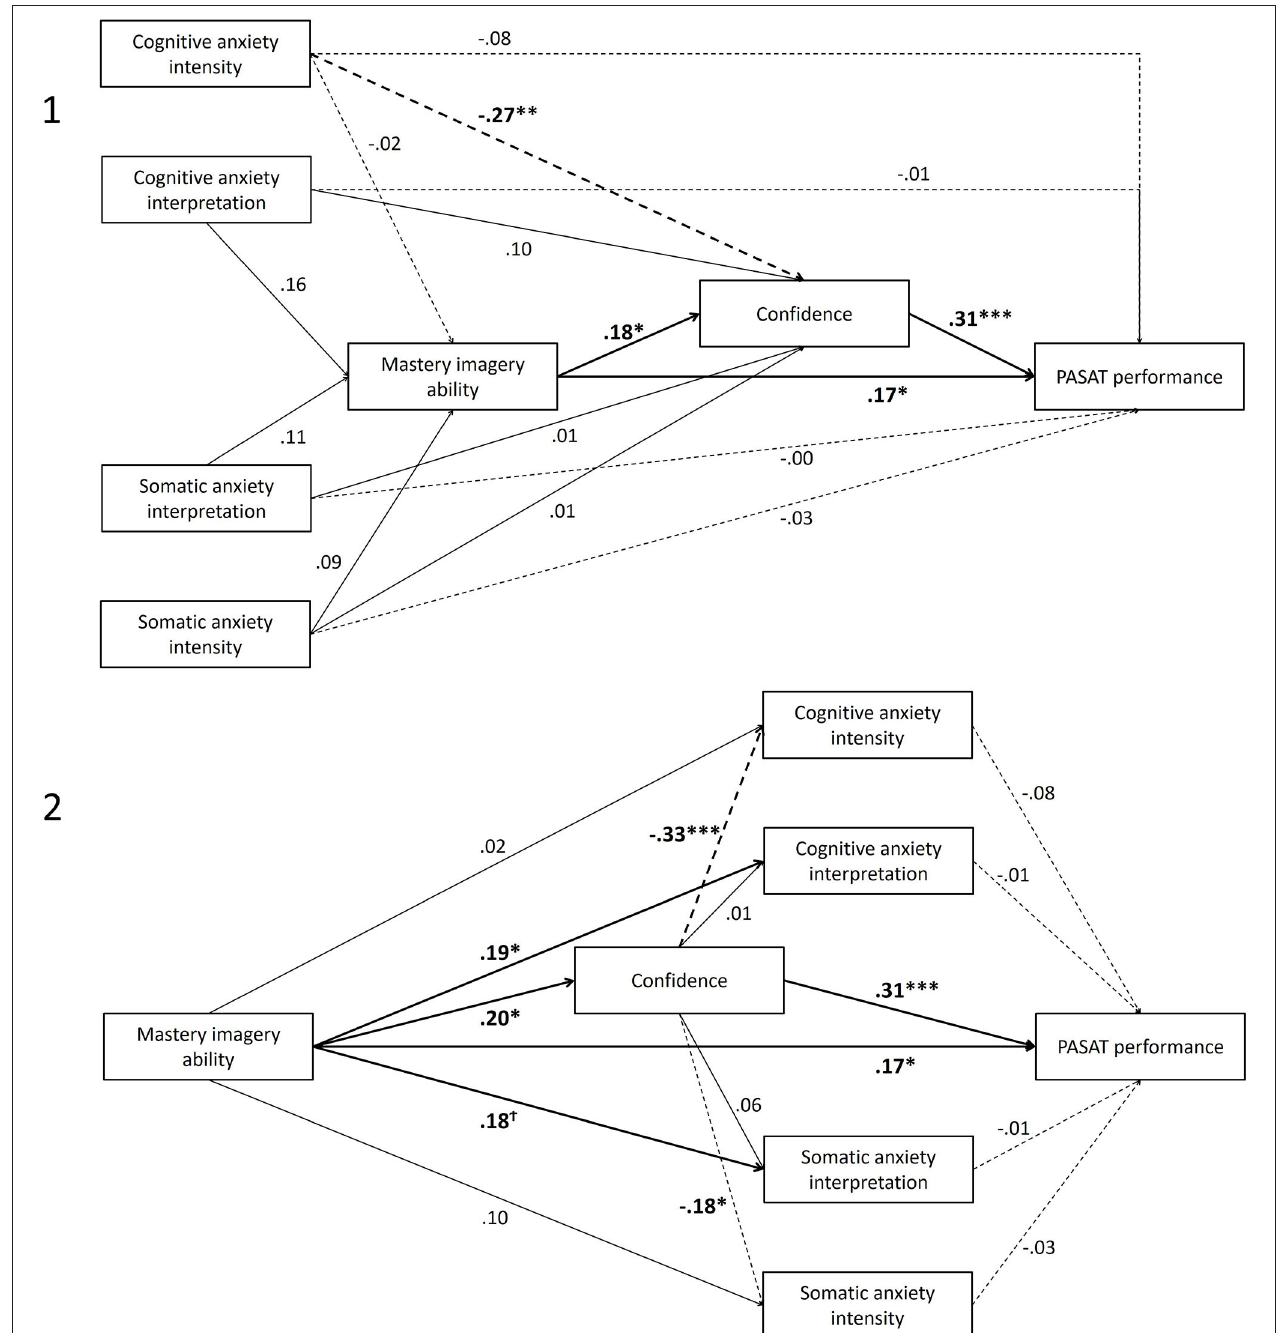
FIGURE 3 | Results of alternate model 1 and alternate model 2. All values are standardized coefficients. *** p < 0.001, ** p < 0.01, * p < 0.05, † p = 0.05. For visual simplicity, controlling variable gender is not presented but was included in all analyses. Full lines represent positive regressions, dashed lines represent negative